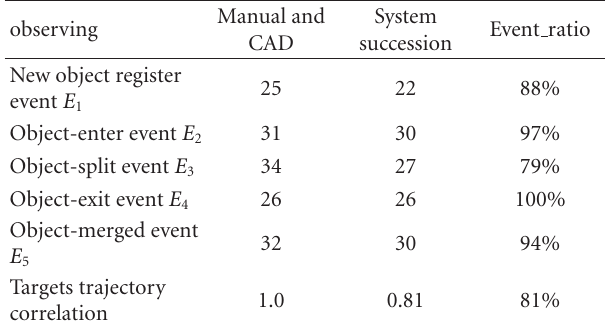
Table 4: Experiment III results; the event-tracking evaluation.